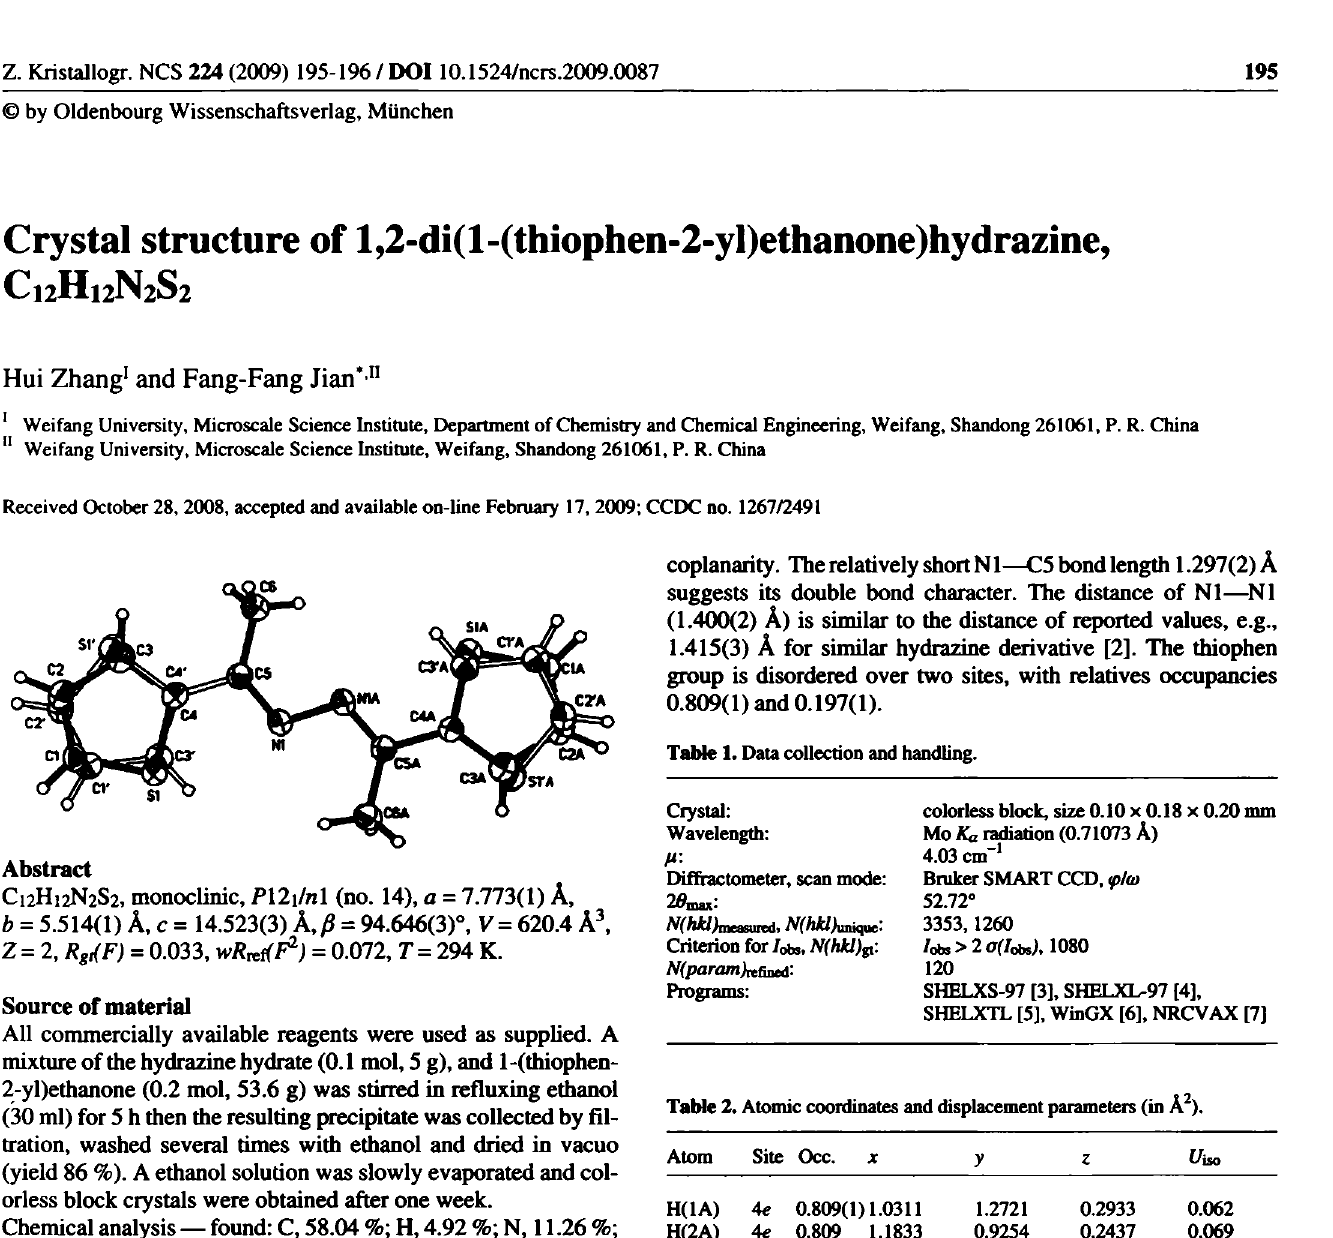
Table 2. Atomic coordinates and displacement parameters (in A 2 ).